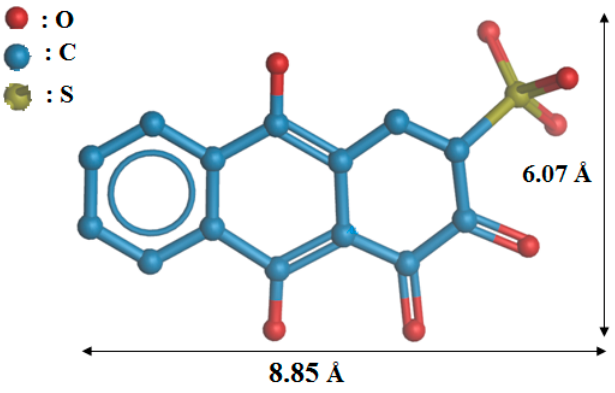
Figure 1. Molecular structure and sizes of Alizarin Red S (ARS) calculated with molecular modeling system Mol. Browser